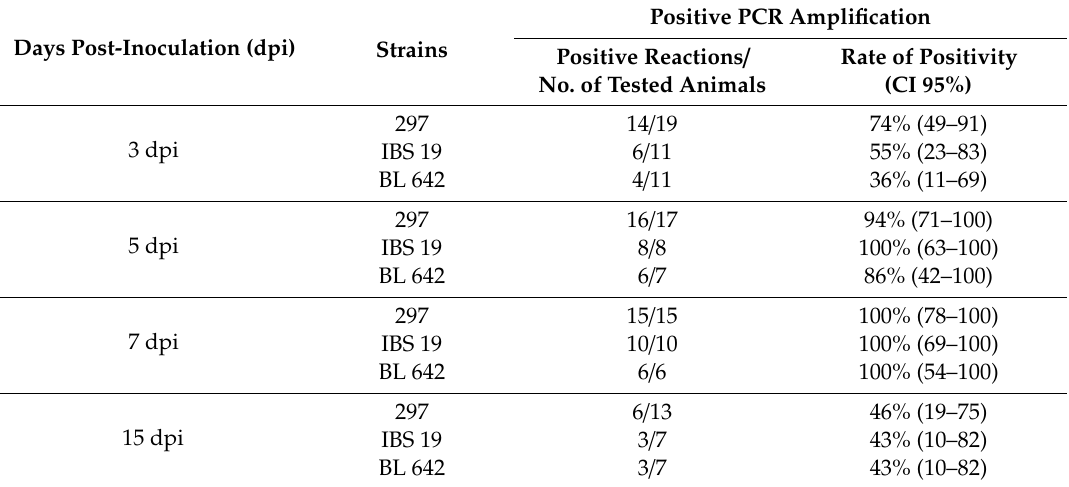
Table 1. Detection of Borrelia burgdorferi sensu stricto (ss) DNA in the skin of infected mice 3, 5, 7, or 15 days post-inoculation (dpi). This table presents the results of all the mice included in the study. Abbreviations: CI 95%, 95% confidence interval; PCR, polymerase chain reaction.